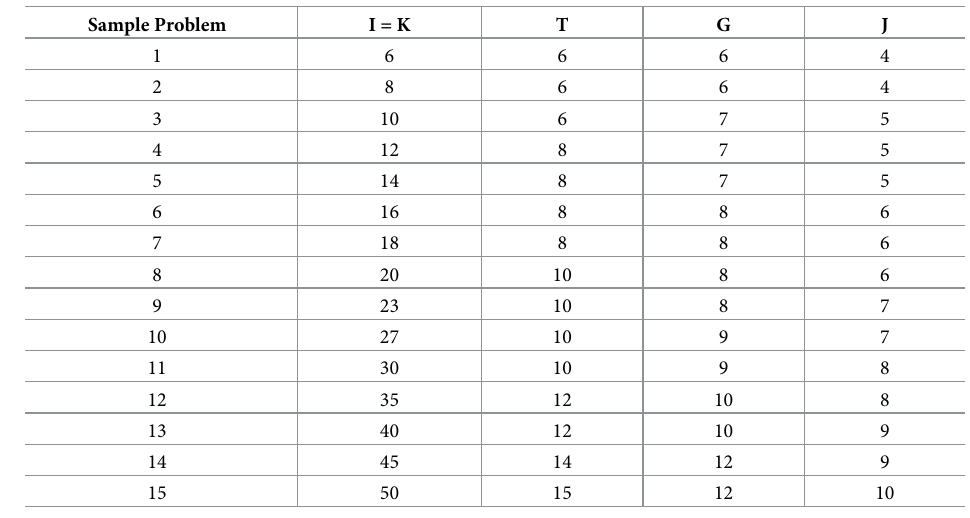
Table 10. The size of the designed test